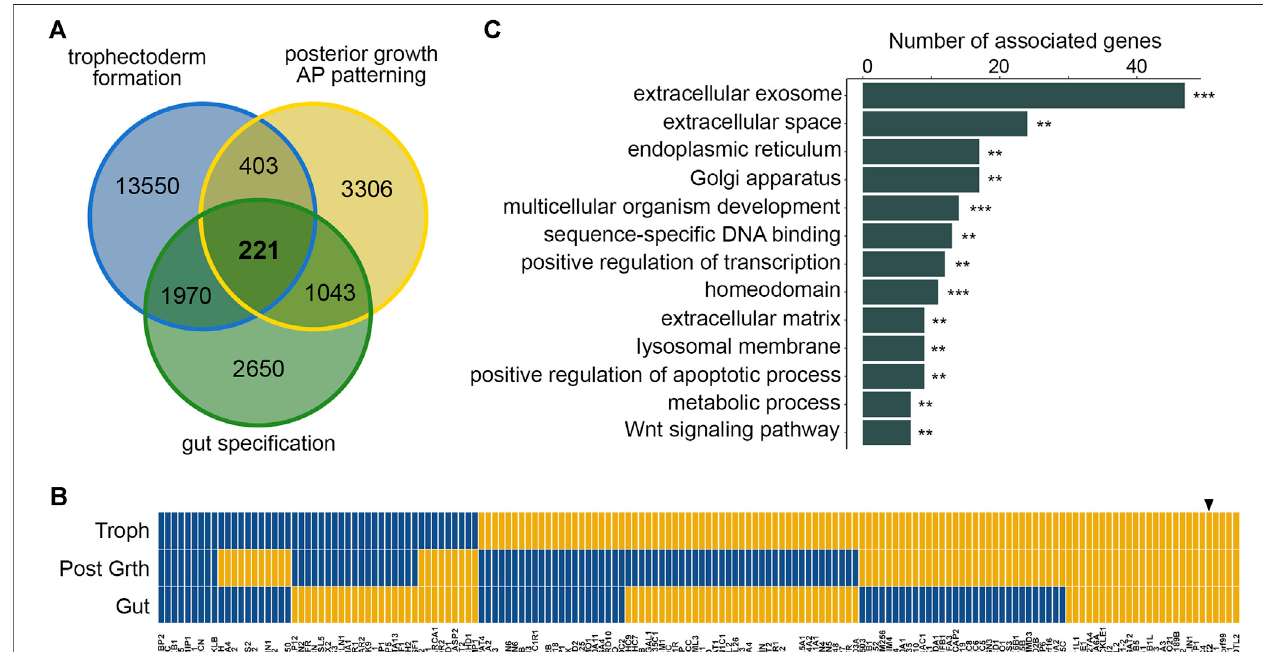
FIGURE 1 | A core set of DEGs responsive to CDX2 in mouse development. ( A ) Comparison of differentially expressed genes between Cdx2-overexpressing vs wildtypeEScells(trophectodermformation;blue),E8Cdx-nullvswildtypeembryos(posteriorgrowth,APpatterning;yellow)andintestinalepithelialcellsofE16Cdx2 − / − vs wild type embryos (gut speci fi cation; green) showing the core set of 221 mouse DEGs. ( B ) Correlation map of the expression changes of the mouse core set of 162/ 221 DEGs having human orthologues, at the three developmental steps (yellow: up-regulation; blue: down-regulation): trophectoderm formation (Troph; Cdx2- overexpressing vs wild type ES cells), posterior growth (Post Grth; E8 wild-type vs Cdx-null embryos) and gut speci fi cation (Gut; E16 wild-type vs Cdx2 − / − embryos). At eachdevelopmentalstage,themapillustratesthecomparisonoftheCdx2-expressingsamplesvstheCdx2non-expressingcounterparts.ThearrowheadshowsCDX2. ( C ) Ontology analysis of the set of 162 human orthologues to the mouse core set of DEGs. ** p < 0.01, *** p <